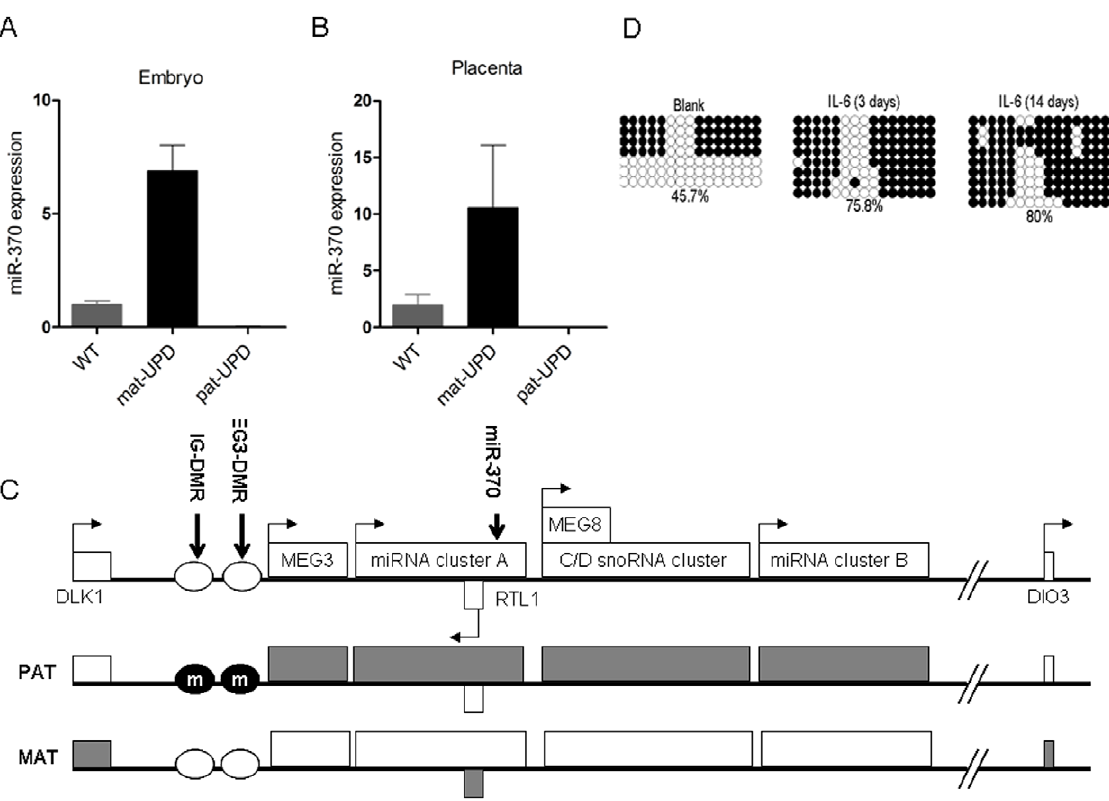
Figure 3. miR-370 is normally imprinted. A and B. Maternal, but not paternal, UPD(12) disomy mice express miR-370. To establish the imprinting status of miR-370, TaqMan qPCR was carried out on wild-type mice and mice with maternal and paternal uniparental disomy for chromosome 12 (WT, mat-UPD and pat-UPD respectively). miR-370 expression is strongly elevated in mat-UPD embryos and is absent from pat-UPD embryos, showing that miR-370 is a maternally expressed imprinted gene. Mean 6 SD, *P , 0.05, **P , 0.01. C. miR-370 is located within the DLK- DIO3 domain. The genomic map of imprinted DLK-DIO3 control domain is displayed: gray rectangles indicate silenced alleles and the blank rectangles indicate expressed alleles, the paternally (PAT) expressed alleles are DLK1, RTL1 and DIO3. The maternally (MAT) expressed non-coding RNA genes include maternally expressed gene 3 (MEG3), anti-RTL1 (encodes the smaller miR cluster A), maternally expressed gene 8 (MEG8) (encodes small nucleolar RNA (snoRNA) cluster) and the larger miR cluster. IG-DMR and MEG3-DMR are methylated on the paternal chromosome indicated by the encircled letter m. miR-370 is a member of the cluster A of miRs and located within the DLK1-DIO3 domain. D. IL-6 induces gain of methylation at IG-DMR-CG6 in HuCCT1 cells. Each line indicates a single clone (either of maternal, or paternal origin), and each circle denotes the cytosine of a CpG site; filled and open circles represent methylated and unmethylated cytosines, respectively. The number at the bottom indicates the percentage of methylated cytosines.